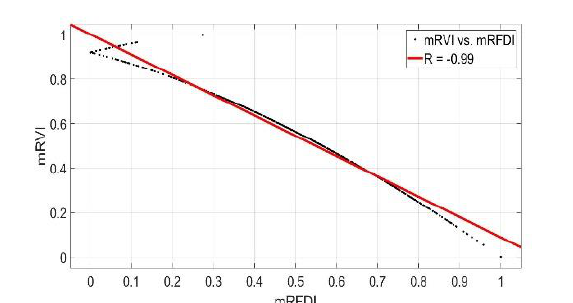
Figure 9. Correlation analysis between mRVI and mRFDI.  Annual Distributions of the Indices Boxplots were created to see the distribution of the optical and radar vegetation indices, NDVI, mRVI, and mRFDI, annually in the Figures 10, 11 and 12, respectively.